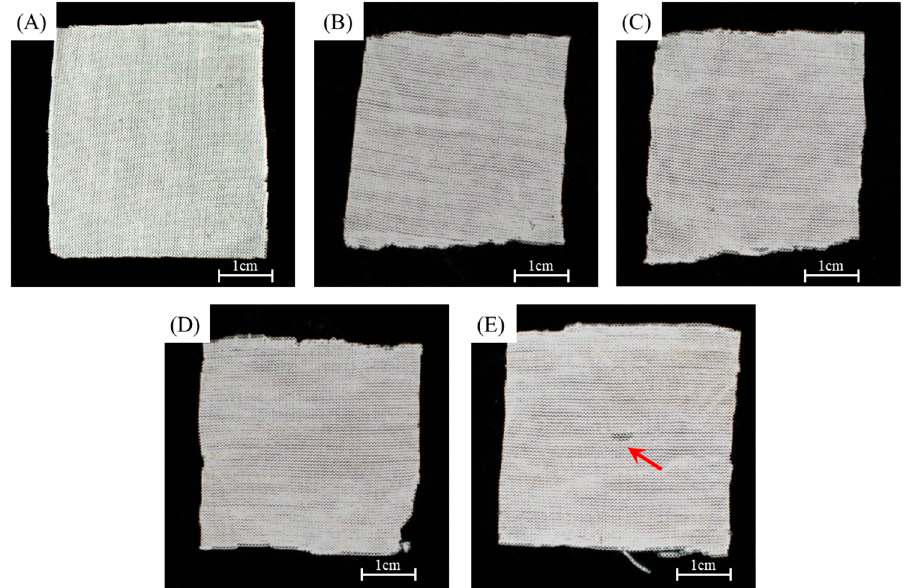
Figure 6. Digital images of ( A ) fresh multi-filament PLA/PHB fabrics, and multi-filament PLA/PHB fabrics after eight weeks of immersion in ( B ) static seawater, ( C ) aerated seawater, ( D ) UV-lighting static seawater, and ( E ) UV-lighting aerated seawater. Note: the red arrow indicated the broken point in the fabrics.